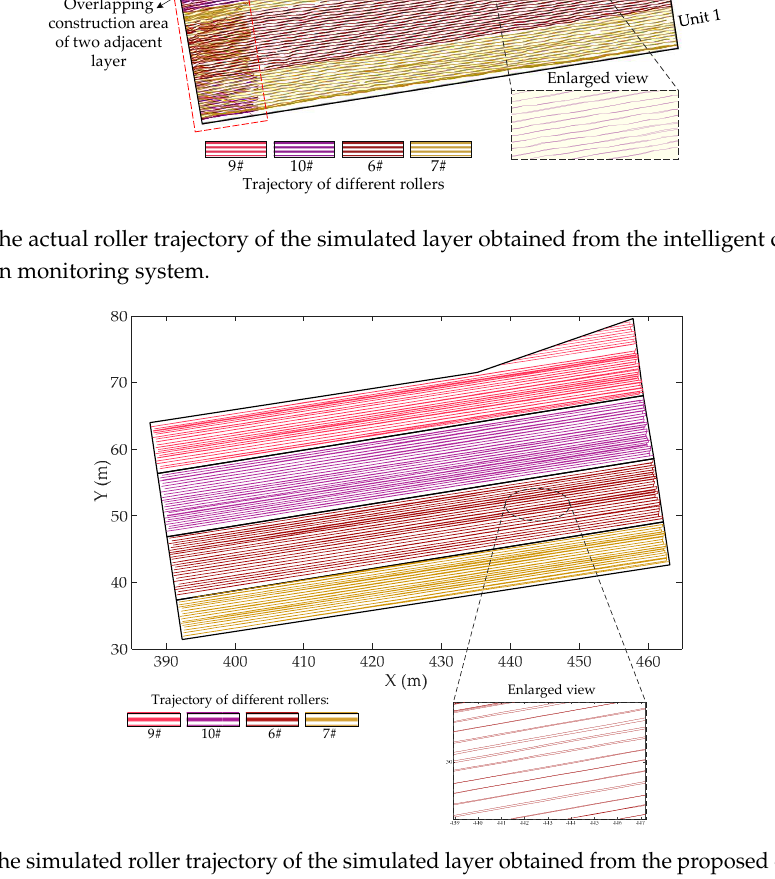
Figure 7. The simulated roller trajectory of the simulated layer obtained from the proposed compaction construction simulation model.